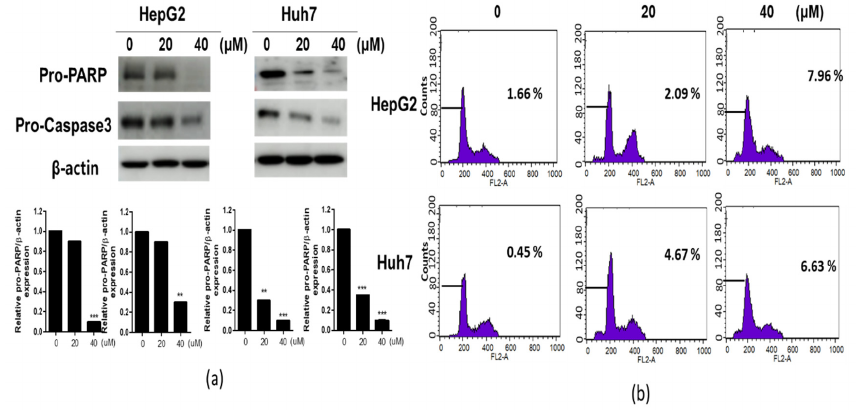
Figure 2. Effect of CB-PIC on apoptosis related proteins in HepG2 and Huh7 cells. ( a ) HepG2 and Huh7 cells were treated with CB-PIC (0, 20 or 40 μ M) for 24 h. Cell lysates were prepared and sub- jected to Western blotting for procaspase-3 and pro-PARP. Graphs represent relative level of protein expression / β -actin. ( b ) HepG2 and Huh7 cells were treated with CB-PIC (0, 20 or 40 μ M) for 24 h. The cells were fixed with 70% ethanol, stained with propidium iodide (PI) and analyzed by flow cytometry. Data represent means ± SD. ** p < 0.01 and *** p < 0.001 versus untreated control. 2.3. CB-PIC Suppressed the Expression of HK2 and PKM2 and Reduced the Production of Lactate in HepG2 and Huh7 Cells To confirm the effect of CB-PIC on PKM2 in different cancer cell lines, Western blot- ting was performed in CB-PIC-treated HepG2, LNCaP, A549, and HCT116 cells. CB-PIC effectively suppressed the expression of PKM2 in HepG2 cells, while it weakly attenuated the expression of PKM2 in HCT116 cells but not in LNCaP and A549 cells (Figure 3a).To confirm whether or not the anti-glycolytic effect of CB-PIC is associated with HK2 and PKM2, Western blotting was performed in CB-PIC-treated HepG2 and Huh7 cells. CB- PIC attenuated the expression of HK2 and PKM2 in HepG2 and Huh7 cells (Figure 3b). Likewise, CB-PIC reduced lactate production in HepG2 and Huh7 cells (Figure 3c). Figure 3. Effect of CB-PIC on expression of HK2 and PKM2 in HepG2 and Huh7 cells. ( a ) Inhibitory effect of CB-PIC on PKM2 in various cancer cell lines (HepG2, LNCaP, A549, HCT116) by Western